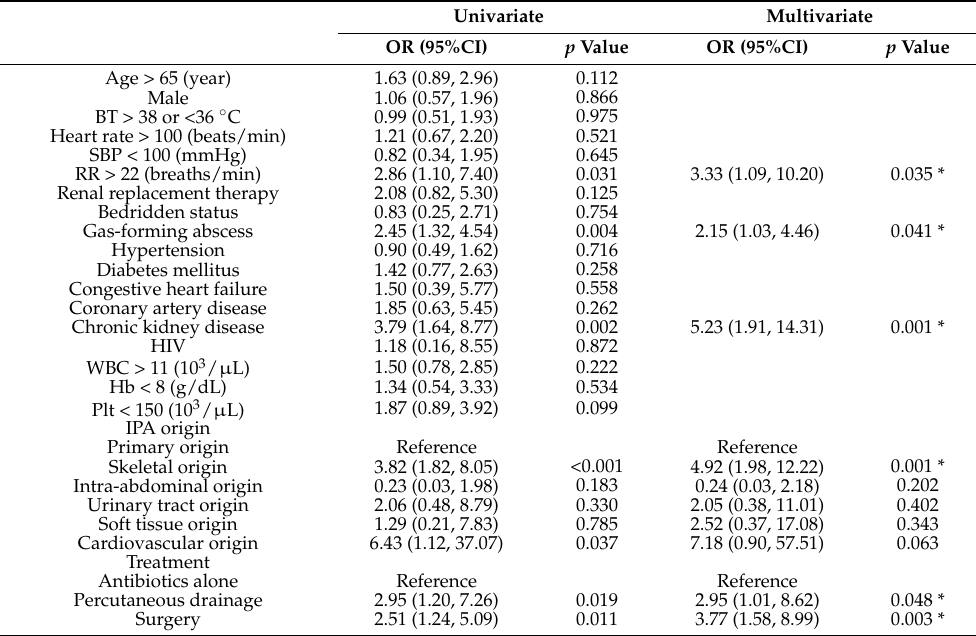
Table 6. Univariate and multivariate analyses of predictors of length of hospital stay longer than 30 days with logistic regression model.